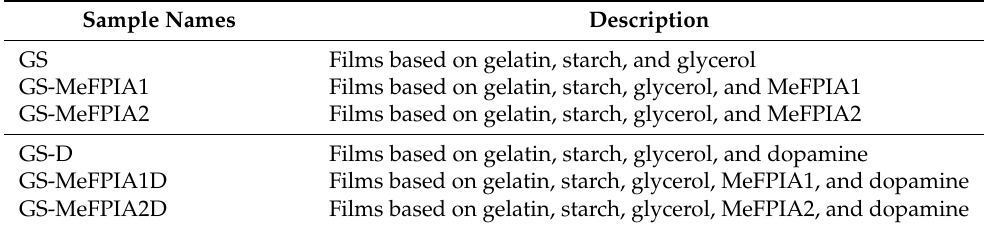
Table 1. Description of gelatin-based films.